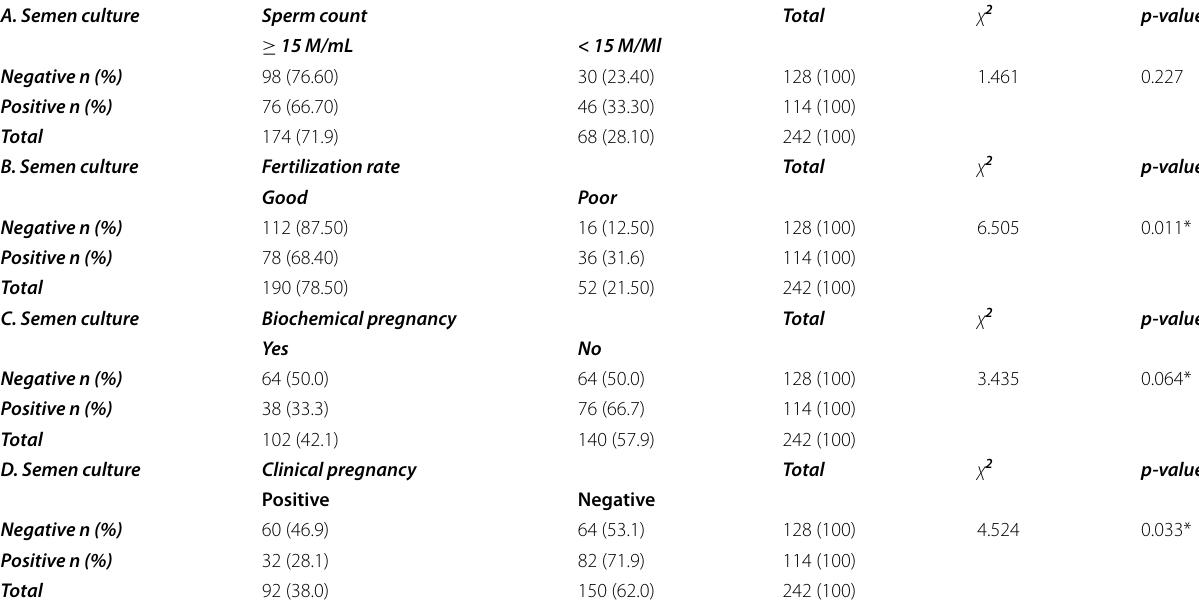
Table 2 Relationship between semen culture and pregnancy outcomes A. Semen